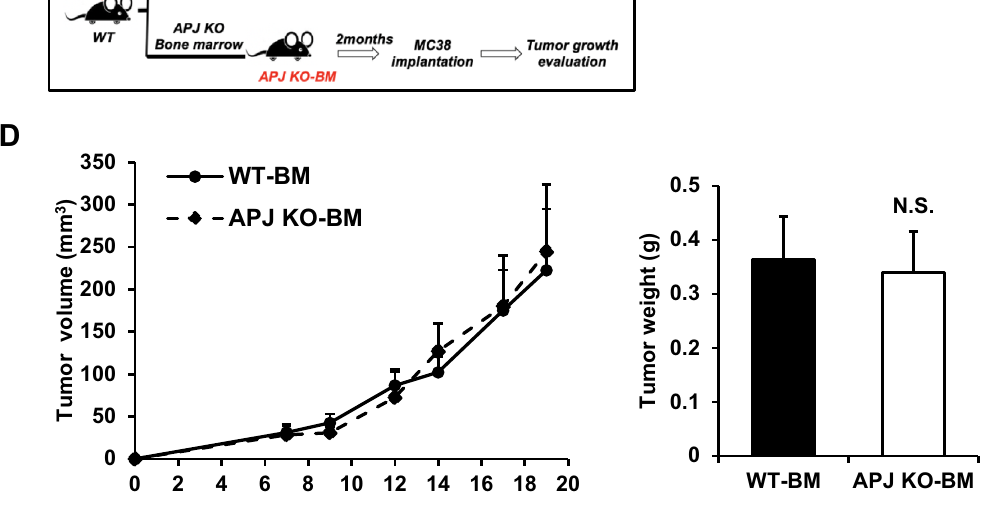
Figure 2. Evaluation of Apelin and APJ expression and involvement of APJ + immune cells in MC38 tumor formation. ( A ) Cells in the MC38 tumor microenvironment at day 19 of tumor cell inoculation were separated into 3 groups by flow cytometry, i.e., CD45+ CD31−, CD45−CD31+ and CD45−CD31− cells. Apelin expression levels were evaluated by qRT-PCR and normalized against GAPDH. ( B ) APJ expression levels were evaluated by qRT-PCR and normalized against GAPDH. ( C ) Schedule of tumor models using WT or APJ-KO bone marrow-transplanted mice (n = 10 for each group). MC38 tumor growth curves were measured until day 19. ( D ) MC38 tumor weights on day 19 after MC38 cell inoculation were calculated (n = 10 for each group). All experiments were repeated at least three times. The error bars indicate mean ± SD and all data were analyzed by two-sided Student’s